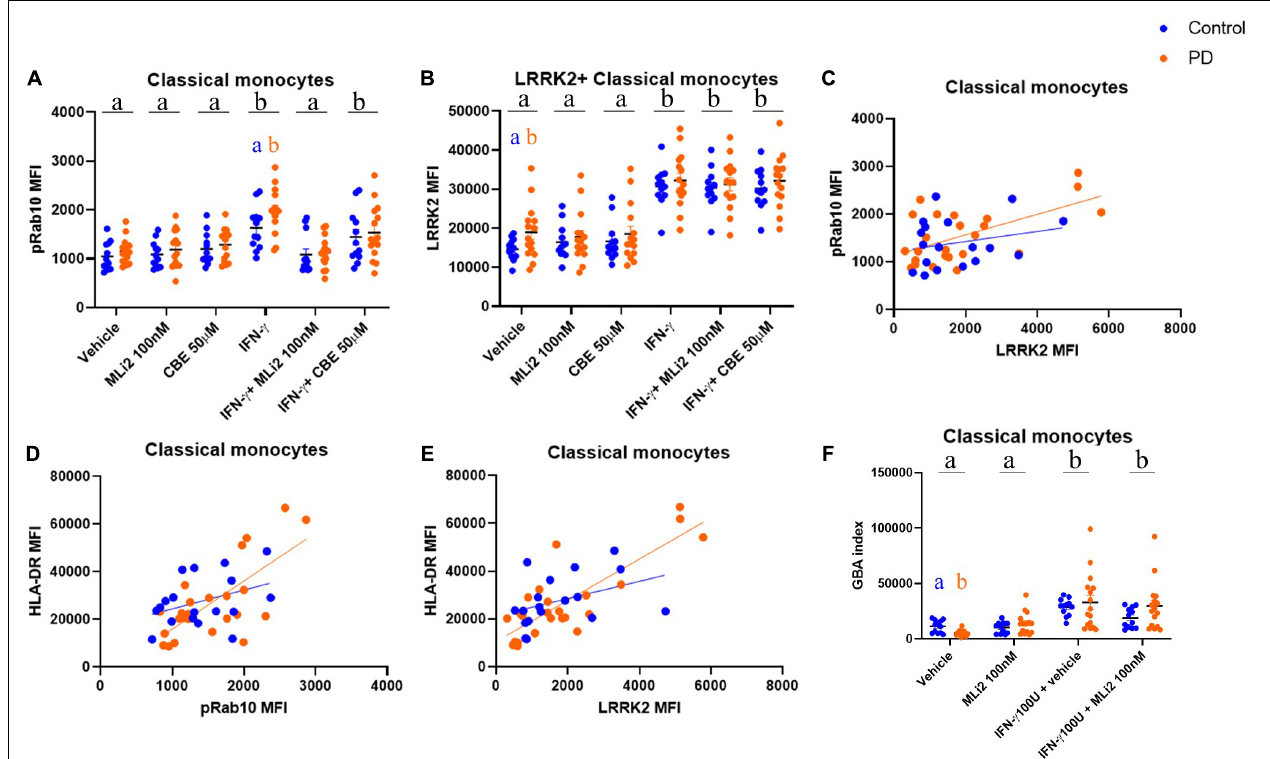
FIGURE 5 | WHOPPA enables identification of increased LRRK2 protein levels and stimulation-dependent enzymatic activity, decreased GBA index in PD monocytes. Cryopreserved PBMCs from iPD-subjects and healthy controls were plated and stimulated with 100U IFN- γ for 18 h in the presence or absence of 100 nM MLi-2 or 50 µ M CBE. Classical monocytes were gated from total PBMCs and assessed for pRab10 MFI (A) and LRRK2 MFI (B) . Bars represent mean ± SEM ( N = 13/15). Two-way ANOVA, Bonferroni post-hoc , groups sharing the same letters are not significantly different ( p > 0.05) whilst groups displaying different letters are significantly different ( p < 0.05). Lower case letters in black at the top of each graph denote main effects of treatment. Lowercase letters in the colors of the two cohorts denote post-hoc analysis of disease status within treatments. pRab10 MFI was plotted vs. LRRK2 MFI [HC r(30) = 0.2430, p = 0.3313; PD r(42) = 0.5877, p = 0.0025] (C) . HLA-DR MFI was plotted vs. pRab10 MFI (E) [HC r(30) = 0.3741, p = 0.1262; PD r(42) = 0.0.7 069, p = 0.0001] (D) or LRRK2 MFI (F) [HC r(30) = 0.3925, p = 0.1072; PD r(42) = 0.8236, p < 0.001] (E) . Pearson r was used to assess individual correlations of slopes of HC and PD. Classical monocytes were gated from total PBMCs and assessed for GBA index, as calculated by PFB-FDGlu MFI ( − CBE)–PFB-FDGlu ( + CBE) (F)